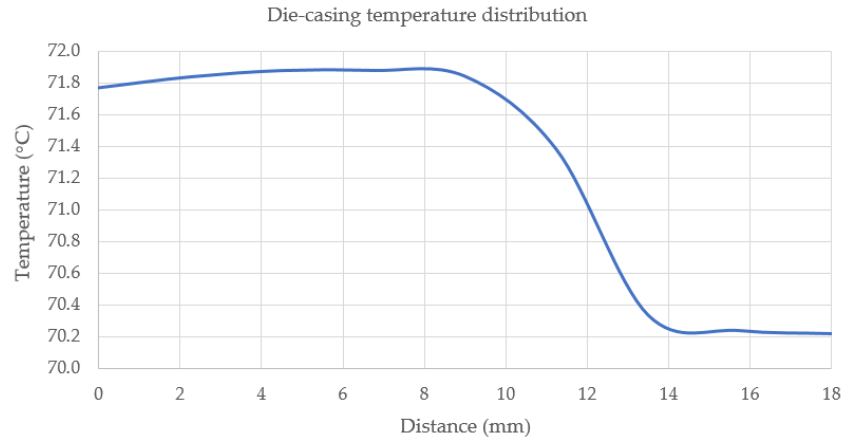
Figure 10. Results of the simulations carried out the temperature on the path between the die of the semiconductor diode and the point of the housing, the temperature of which is closest to the die temperature. The result obtained for Pj = 13.2 W.